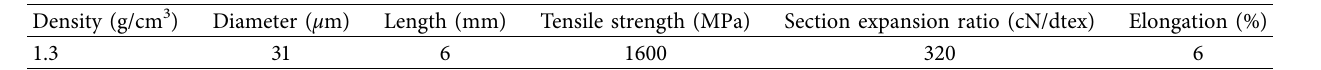
Table 2: Properties of the PVA fiber.